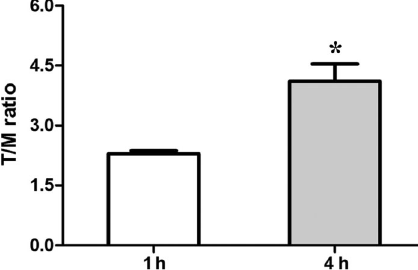
Figure 4. Quantitative analysis of tumor-to-muscle (T/M) ratio evaluated by scintigraphic images. Data are reported as means